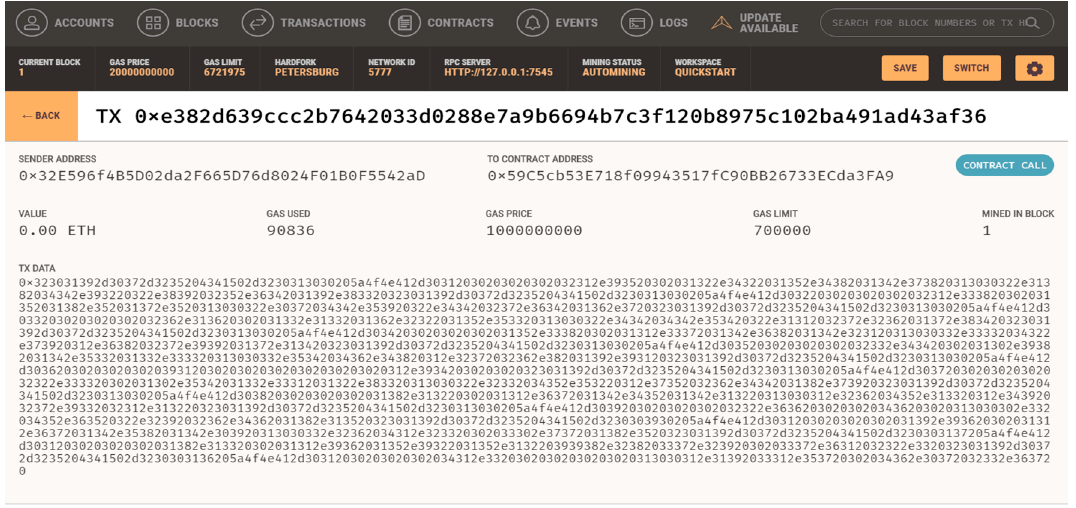
Figure 8. Raw data transaction.